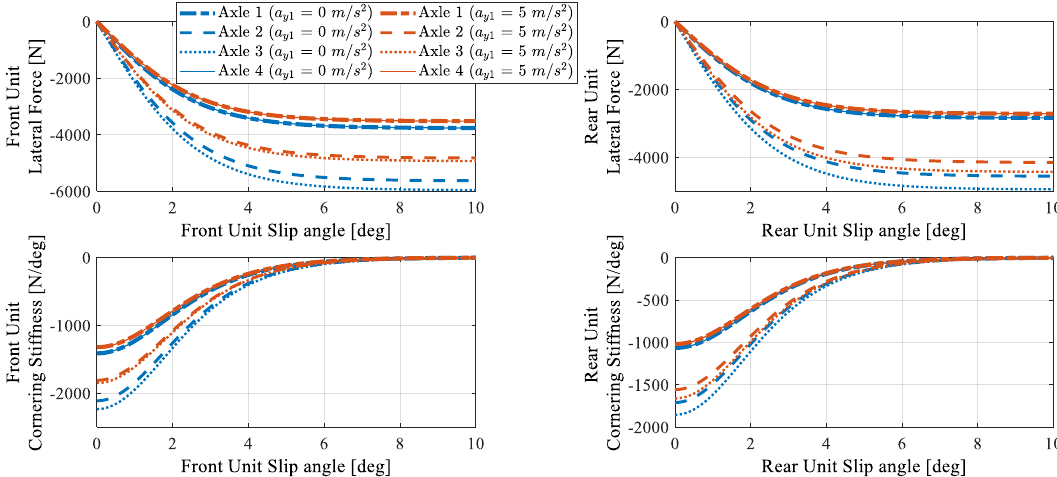
Figure 8. Front ( left ) and rear ( right ) unit axle lateral forces ( top ) and cornering stiffness ( down ) as a function of slip angles for different values of the lateral acceleration.